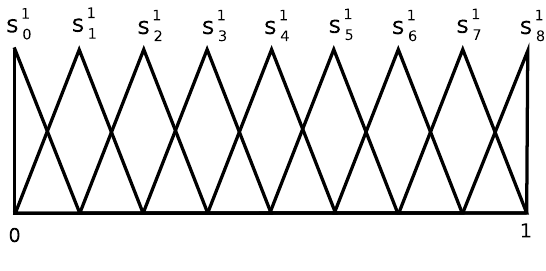
Fig. 2. The linguistic term set S 1